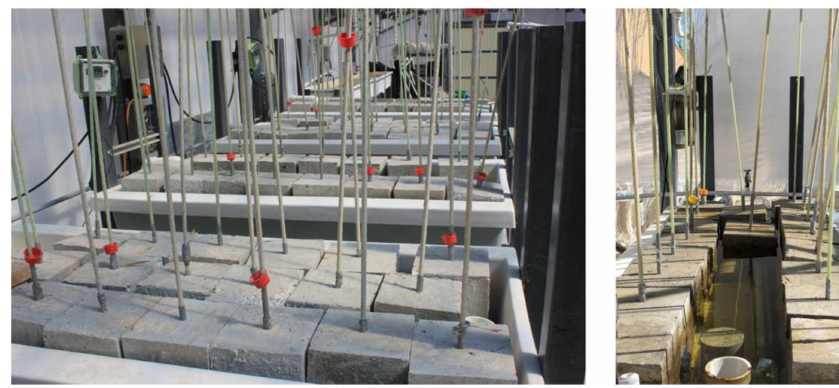
Figure 2. Conditioning exposure of the specimens. Table 2. Experimental maximum values of the bond between the GFRP rebars and the concrete. Rebar